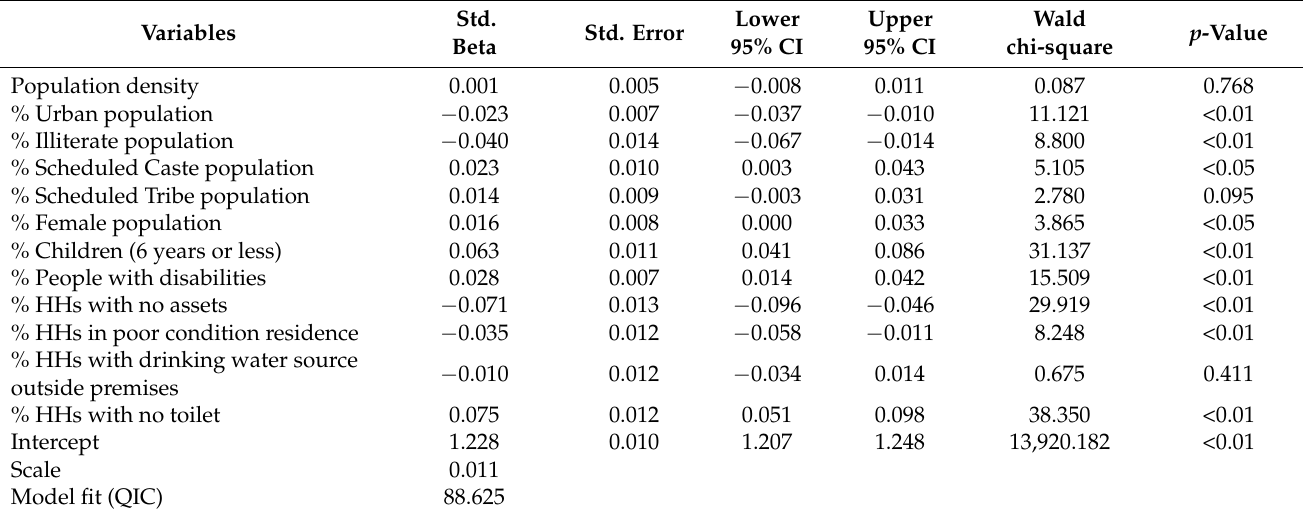
Table 5. GEE for predicting 2016/2010 PM 2.5 concentration ratio ( N =